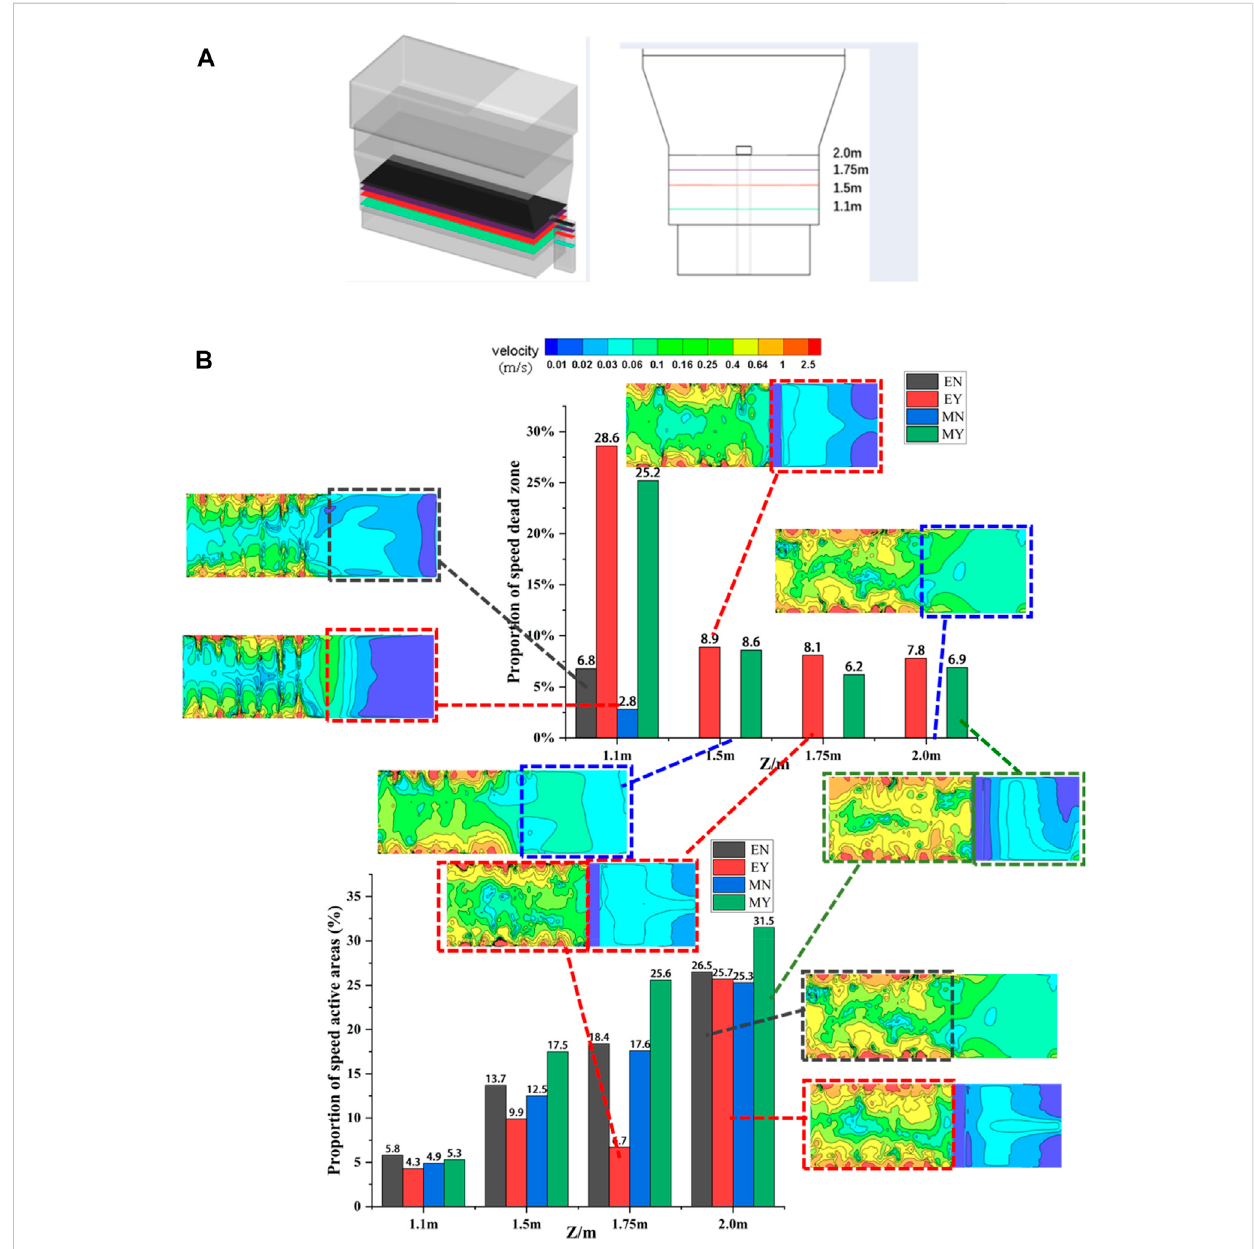
FIGURE 9 Division of height sections (A) and distribution of velocity active and dead zones (B) at 3 seconds under four